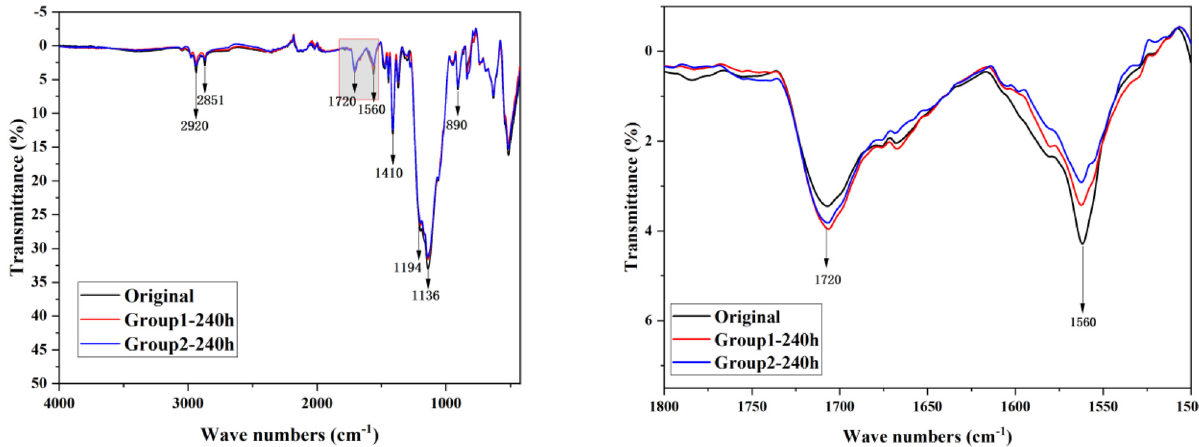
Figure 9: ATR - FTIR spectra of the FPM